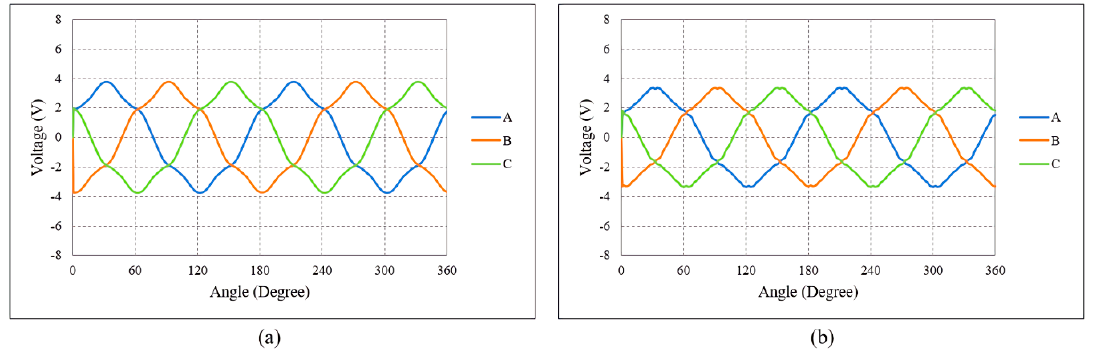
Figure 5. Torque-angle curves of 35CS300 and Somaloy 700 1P motors at an input current of 1 A.